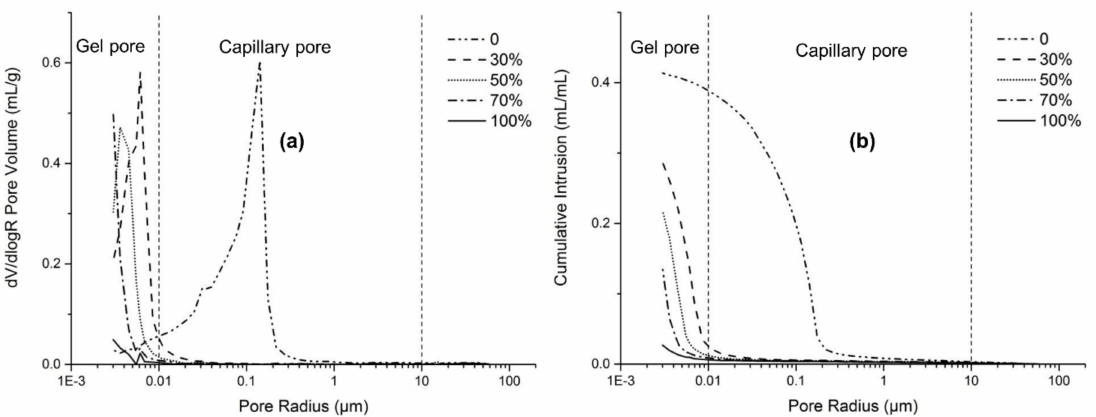
Figure 10. The pore structure ( a ) and the porosity ( b ) of the AAFS paste with di ff erent slag content (the activator modulus is 1.5) at the age of 7